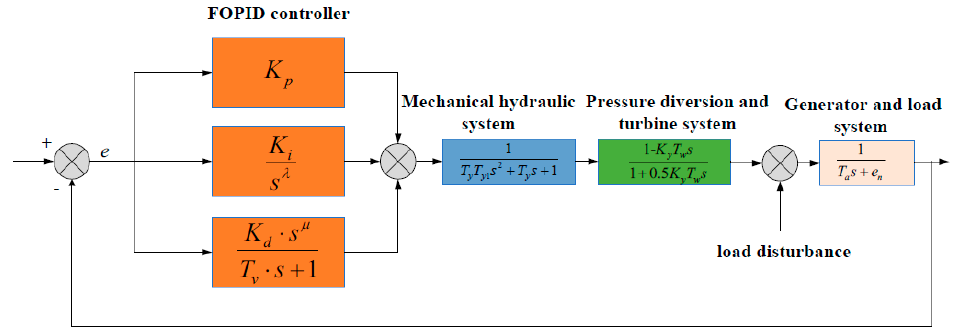
Figure 8. FOPID block diagram of the water turbine governor system.